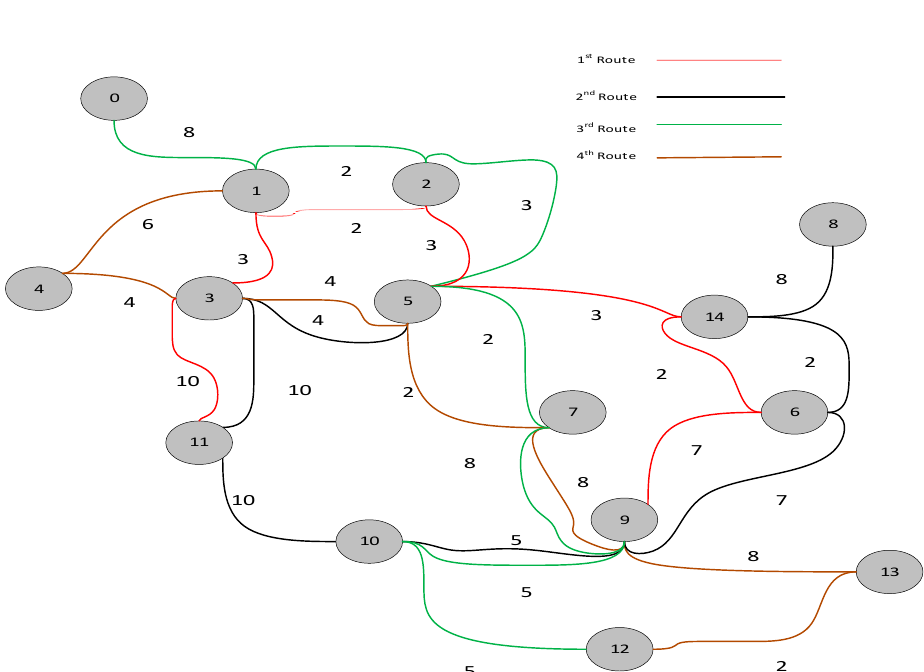
Figure 8. The best route set with four routes produced by CSO.